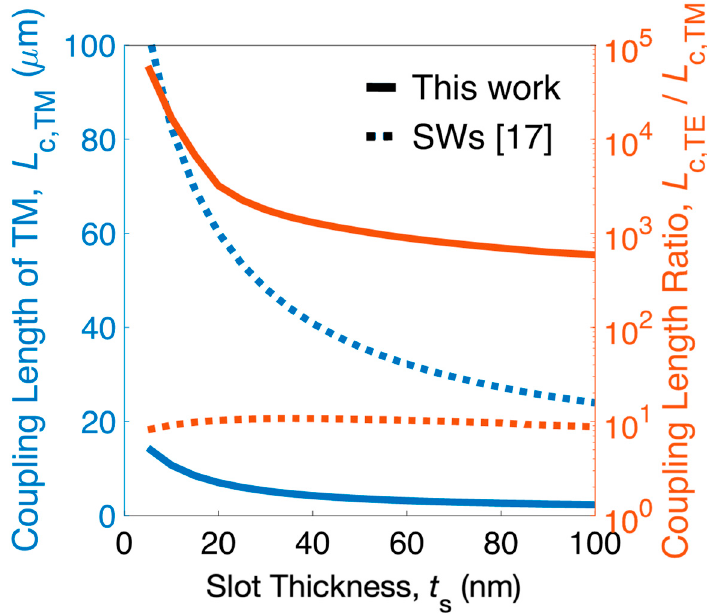
Figure 3. (left axis) Coupling length of TM mode L c, TM TM and (right axis) coupling-length ratio L c,TE / L c, versus t s for the present PBS and the SWs.